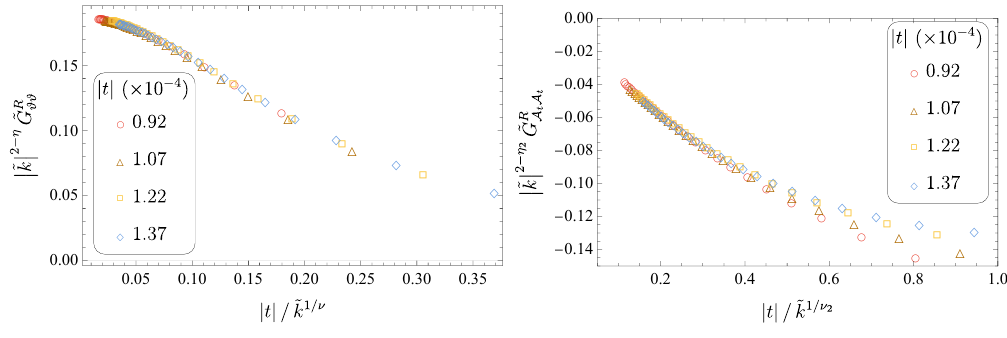
and | ˜ k | 2 − η ˜ G R with respect to | t | / ˜ k 1 /ν , A t A t ϑϑ